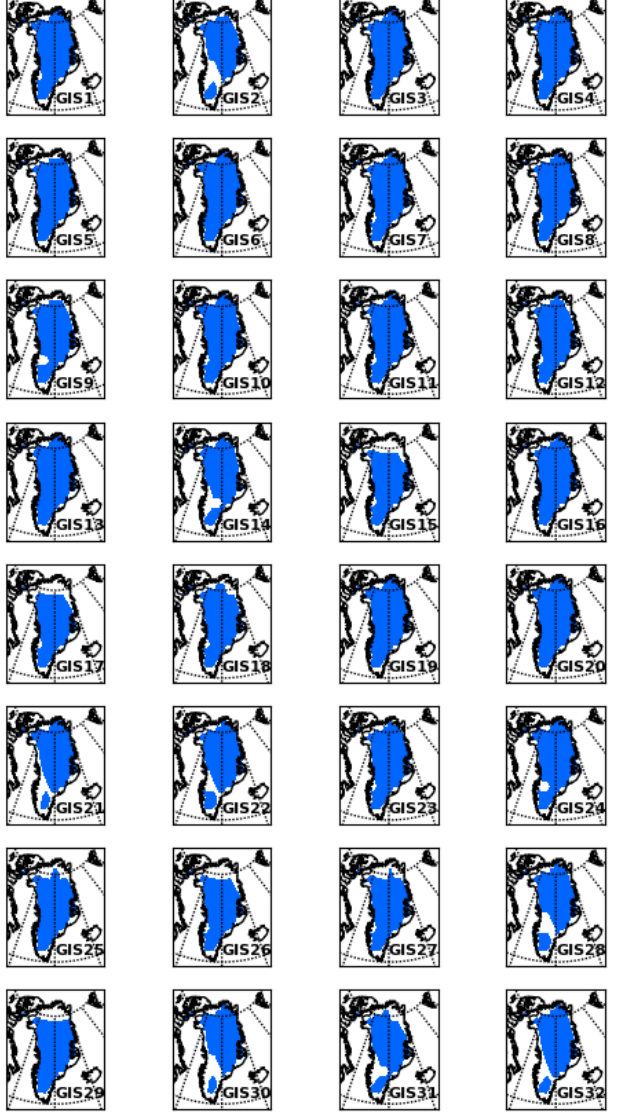
Figure A2. Land-ice mask of LIG GIS morphologies used in the 32 simulations that examine the joint impact of modified Arctic sea ice retreat and modified GIS morphology. See Table A1 for more details.